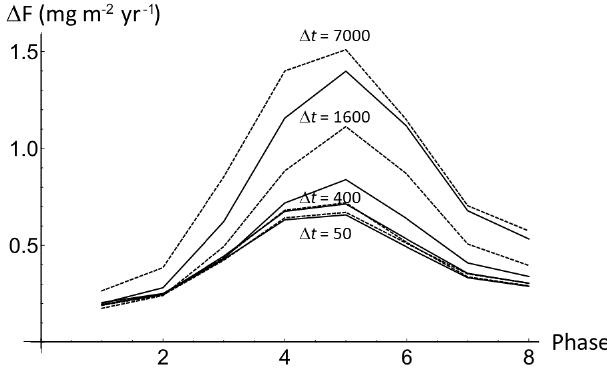
Figure 10. The transition scale τ c estimated in two ways for each of the eight phases and from two definitions of the phases. The first method (solid lines) used a bilinear fit to the (logarithm) of the Haar q = 1 structure function (i.e. mean absolute fluctuation) as a func- tion of log time lag (cid:49)t . To obtain robust results, a small (cid:49)t region with the slope − 0 . 05 and a large (cid:49)t slope + 0 . 25 was imposed with the transition point ( τ c ) determined by regression. This was done for each segment and cycle. For each phase there were thus eight transition scales, which were used to calculate the mean of the loga- rithm of τ c and its standard deviation. Results are shown for dimen- sional (segments, blue) and non-dimensional time (cycles, black). The second method used to estimate τ c was graphical and relied on a somewhat subjective fitting of scaling regimes and transitions, but without imposing small and large (cid:49)t slopes (exponents H ). The results are shown in dashed lines; they are quite similar, although we can note some differences for the first phase (dimensional, blue) and the middle phases (non-dimensional, black). There is also con- siderable cycle-to-cycle spread that was quantified by the standard deviations. In order to avoid clutter, typical spreads are shown by the double headed black arrows. Dashed horizontal lines show the en- semble mean transition scale (about 250 years) as well as ensemble mean for phases 1 and 2 (around 2kyr), which stands out compared to the rest of the phases. The red arrow shows 1 standard deviation for the non-dimensional first phases, while the X marks the value of the Holocene τ c (7.9kyr) just outside the 1 σ limit.